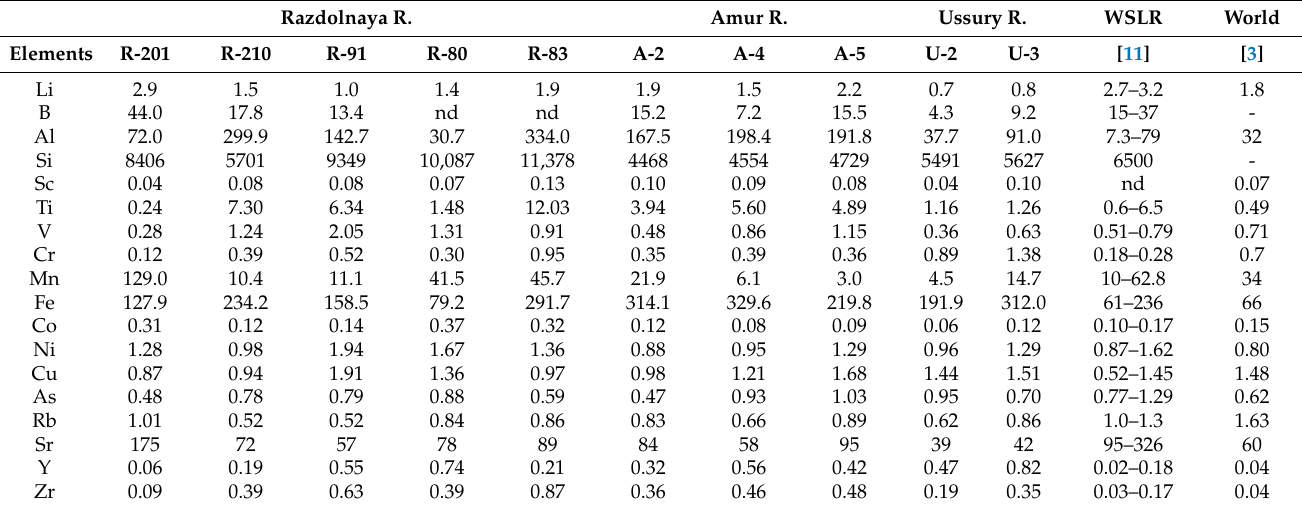
Table 2. Concentration (C i , µ g/L) of 0.45 µ m filterable 1 forms of trace elements in the boreal rivers of the Russian Far East compared with permafrost-free West Siberian lowland Rivers (WSLR) [11] and World average